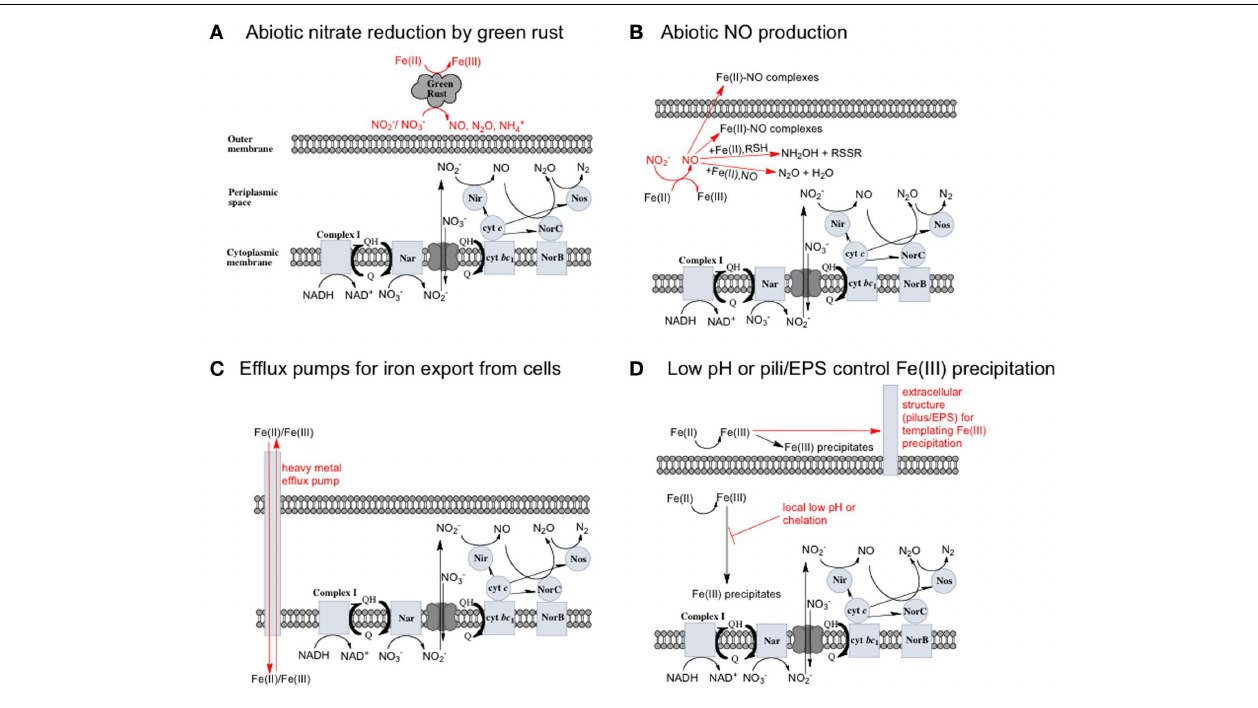
Upregulation of Nor or other NO reductase proteins could protect cells from NO. (C) Soluble Fe(II) or Fe(III) could be exported from cells by heavy metal efflux pumps before it reacts with cellular components (in the case of Fe(II)) or precipitates to form mineral crusts (in the case of Fe(III)). (D) Extracellular polysaccharides or pili may scaffold the precipitation of Fe(III) 2 outside of cells, or a local low pH or chelators may prevent the precipitation of Fe(III) in the